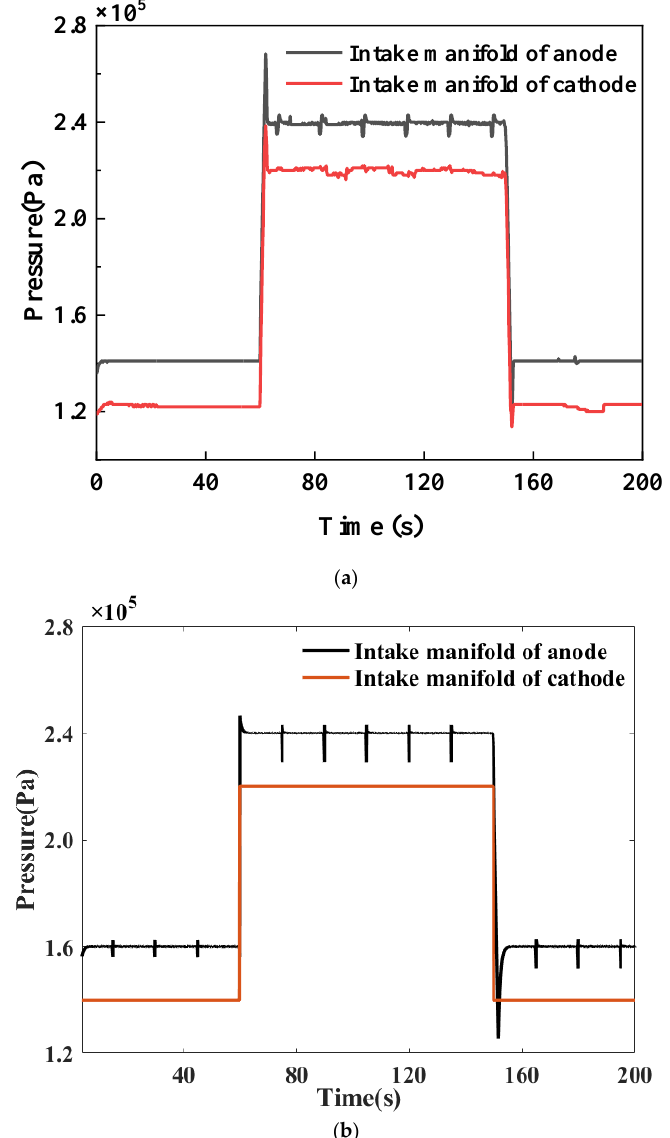
Figure 3. ( a ) Experimental curves of the anode and cathode intake pressure variation during load-up and load-down processes. ( b ) Simulation curves of the anode and cathode intake pressure variation during load-up and load-down processes.